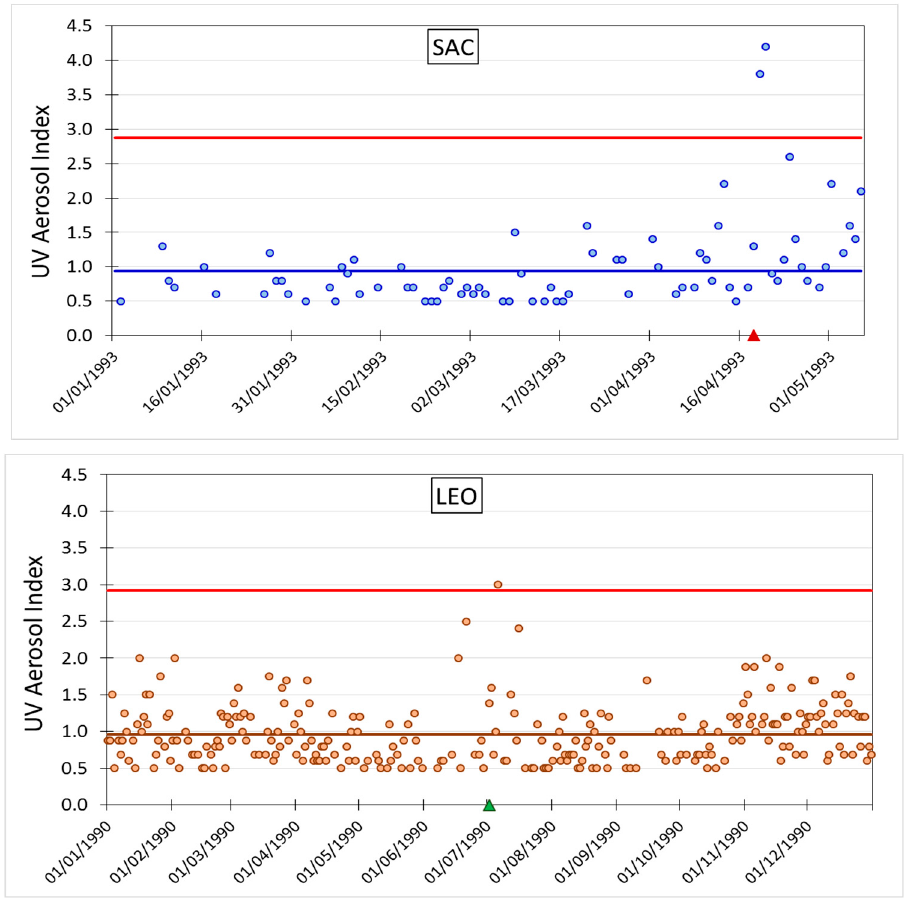
Figure 6. ( Top ) UV aerosol index measured by TOMS instrument onboard Nimbus-7 NASA satellite, at the SAC site. The red arrow indicates the day 18 April 1993 when a significant eruption was produced by the near Lascar volcano; ( Bottom ) similar results for LEO site, with a green arrow indicating the day 2 July 1990 of a large eruption produced by the Puyehue-Cordón Caulle volcanic complex. The horizontal line in the middle of the data indicates the mean value . Source. Goddard Space Flight